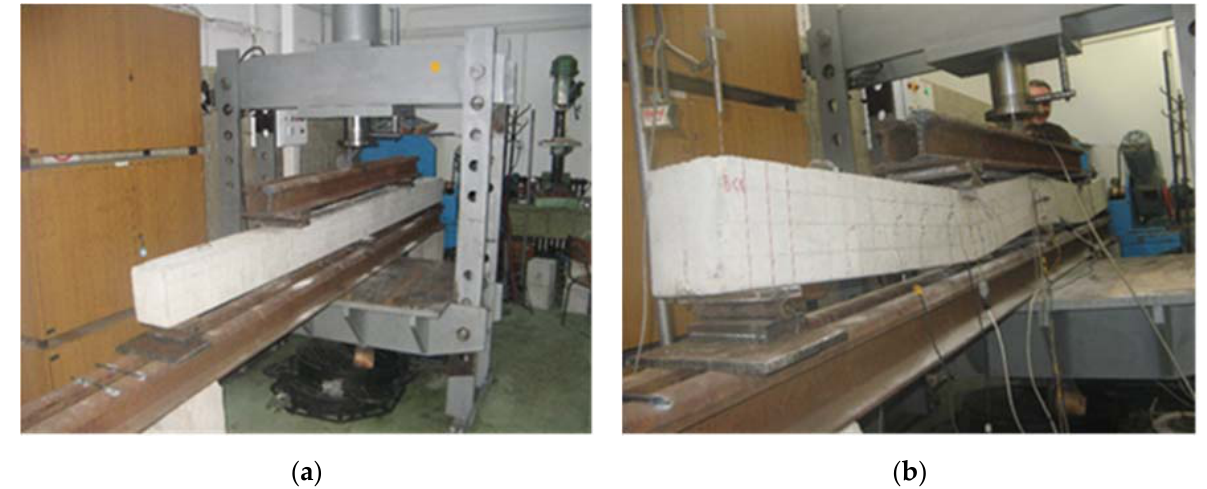
Figure 9. Disposition of the control beam: ( a ) Before loading; ( b ) Under loading.